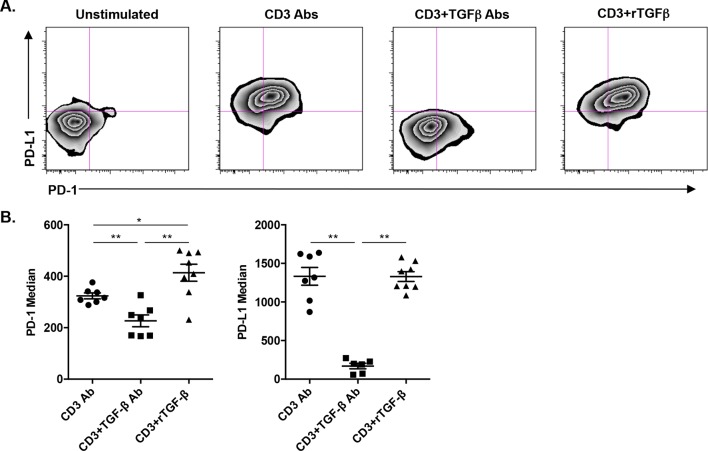
TGFβ modulates PD-1/PD-L1 expression on CD8+ T cells.